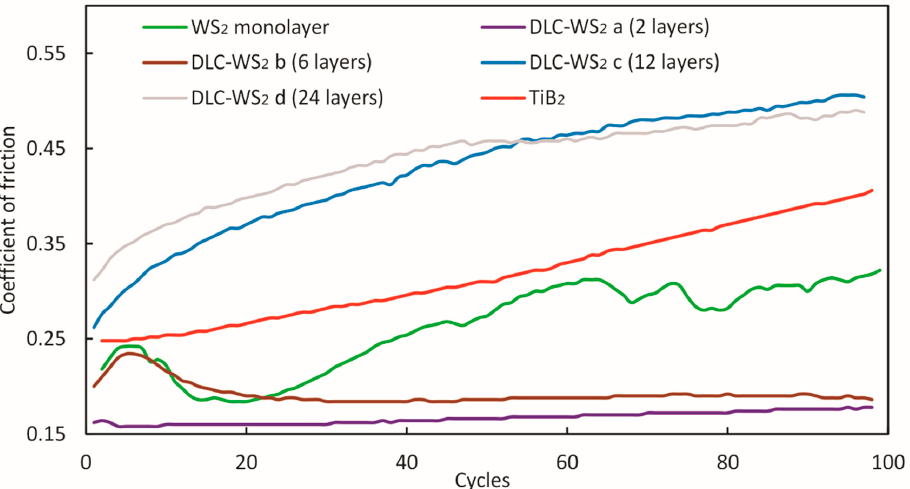
Figure 4. Friction coefficient vs number of cycles for DLC-WS 2 coatings and reference TiB 2 -coated Figure 4 samples. Test conducted by bi-directional scratch test using a fixed WC ball with 5 mm diameter sliding against a coated sample. Constant load 5 N applied for 10 mm distance.